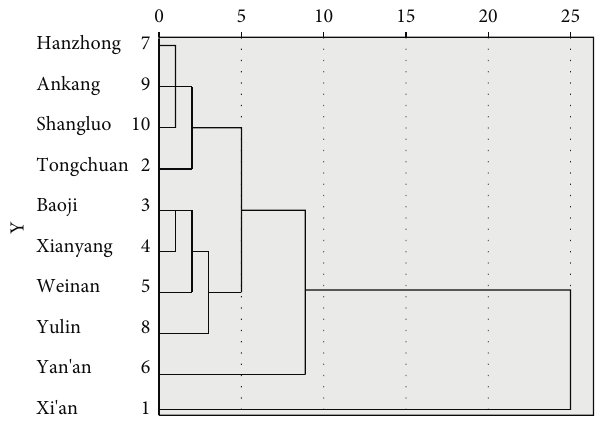
Figure 2: Clustering